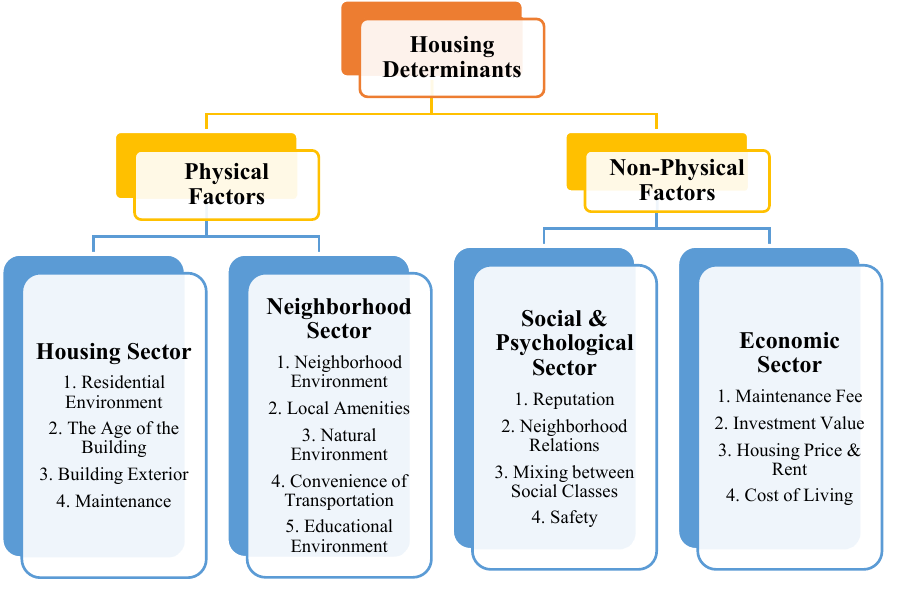
Figure 2. Analysis Model of Research. Table 3. The Middle and Bottom Elements of Housing Determinants for AHP Analysis.